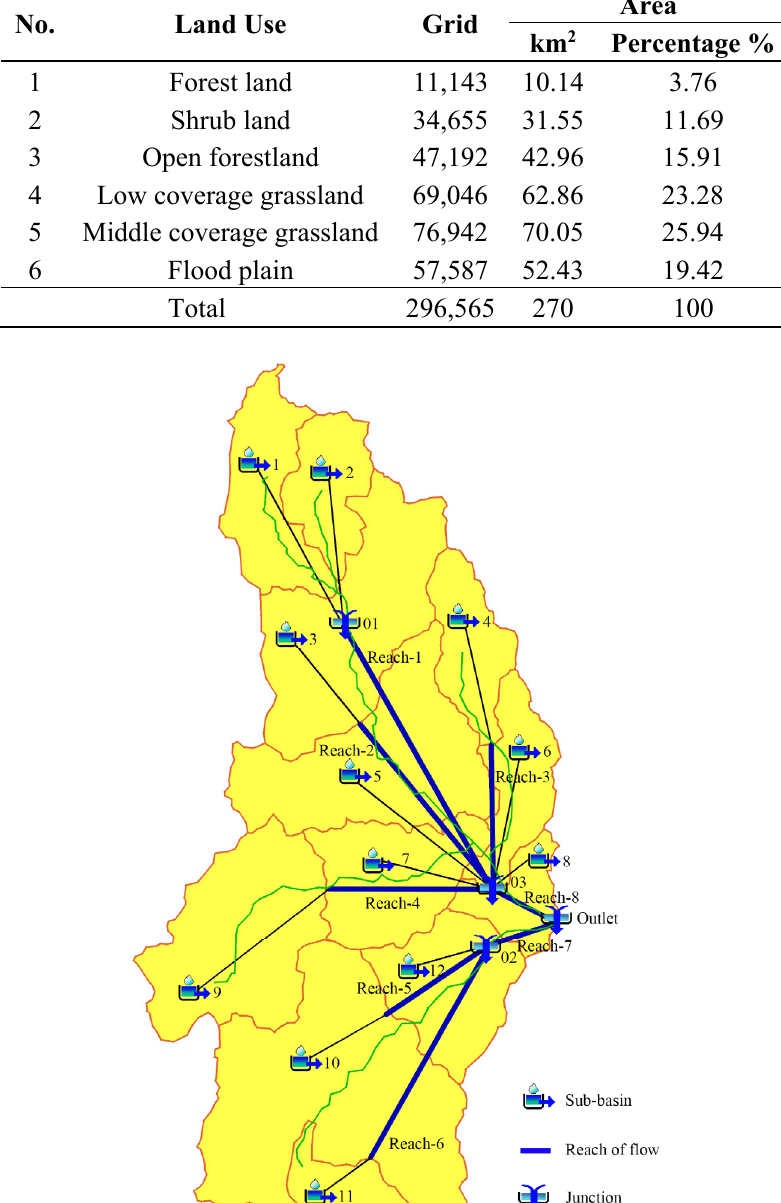
Figure 2. The hydrological model implemented in